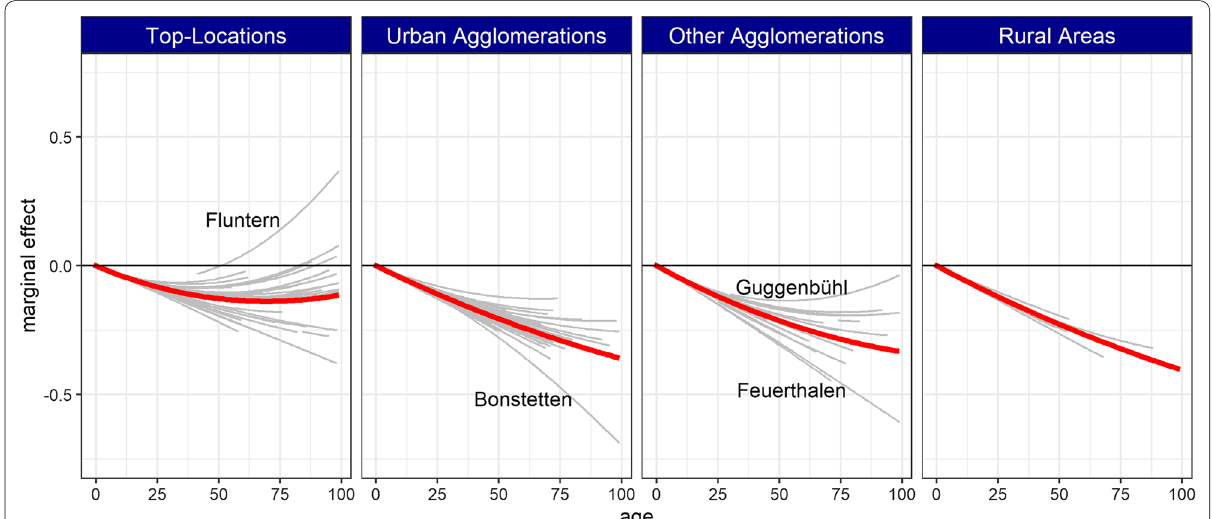
Fig. 6 Back-transformed, aggregated effect of age. The grey curves correspond to the marginal effects as defined in (6) and the red lines are the aggregated marginal effects as defined in (7). The most extreme effects are displayed with their respective cell names, i.e., Fluntern (a district of the city of Zurich), Bonstetten (a suburb to the West of the city of Zurich), Guggenbühl (a district of the city of Winterthur) and Feuerthalen (a district bordering the city of